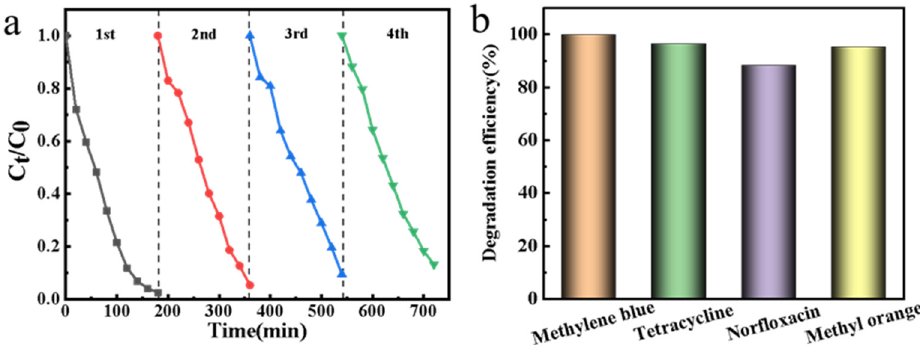
Figure 8. ( a ) Recycling tests of Pd/C@CF for the degradation efficiency of norfloxacin; ( b ) degrada- tion tests of the catalyst on different organic materials (Na 2 S 2 O 8 , 3 mM; norfloxacin, 10 mg/L; solu- tion pH, 7.0; applied potential, − 0.8 V vs. Ag/AgCl; volume of pollutants, 200 mL; electrode area: 2 × 3cm 2 ).